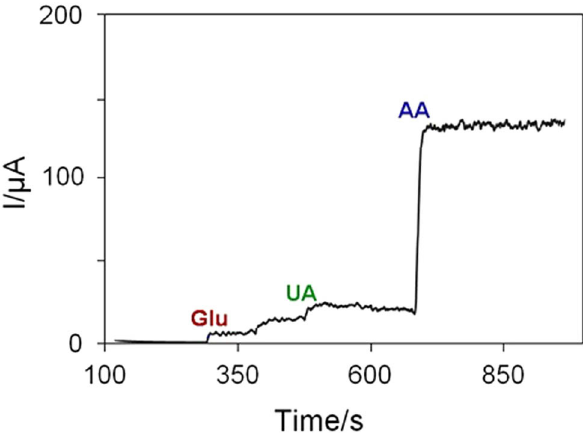
Figure 5: The selectivity of MeGO/PANI sensor in the existence of 10 mM of uric acid and glucose and 5 mM of the analyte in 0.02 M PBS. The applied potential was 0.8 V ( versus Ag/AgCl )